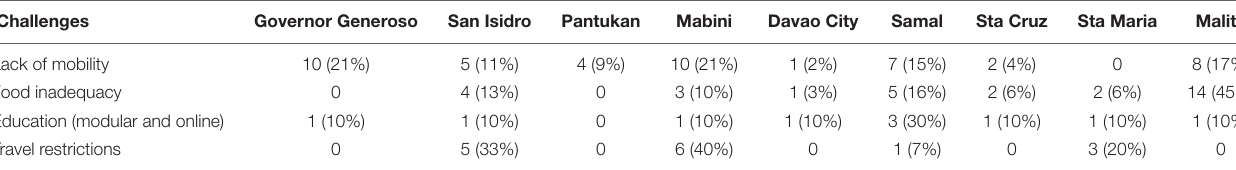
TABLE 5 | Cross-tabulation of challenges experienced by fisher’s family during COVID-19 pandemic.